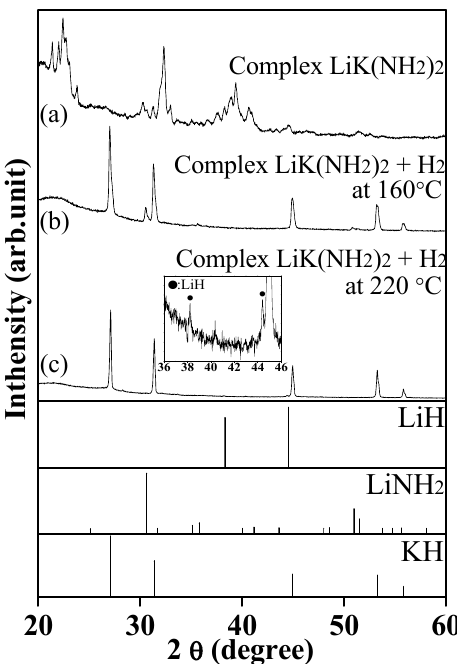
Figure 2. X-ray diffraction (XRD) patterns of complex LiK(NH 2 ) 2 before ( a ) and after ( b ) the hydrogenation at 160 °C for 1 h, and following 220 °C for 4 h ( c ). The inset shows the enlarged figure for profile ( c ) to find the peaks of LiH; XRD pattern of LiH (PDF#78-0838), LiNH 2 (PDF#75-0049), and KH (PDF#65-9244) are referred from databases.